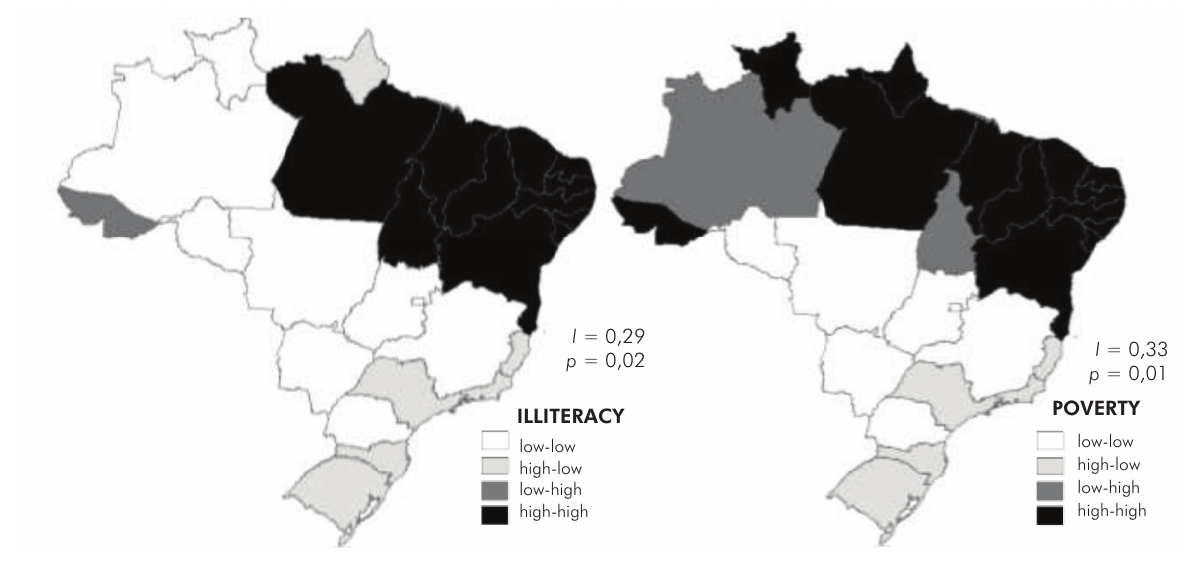
Figure 3. Box map of spatial distribution of Brazilian socioeconomic conditions showing illiteracy and poverty rates in